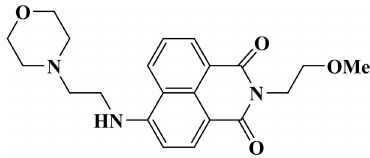
Figure 5. Chemical structure of